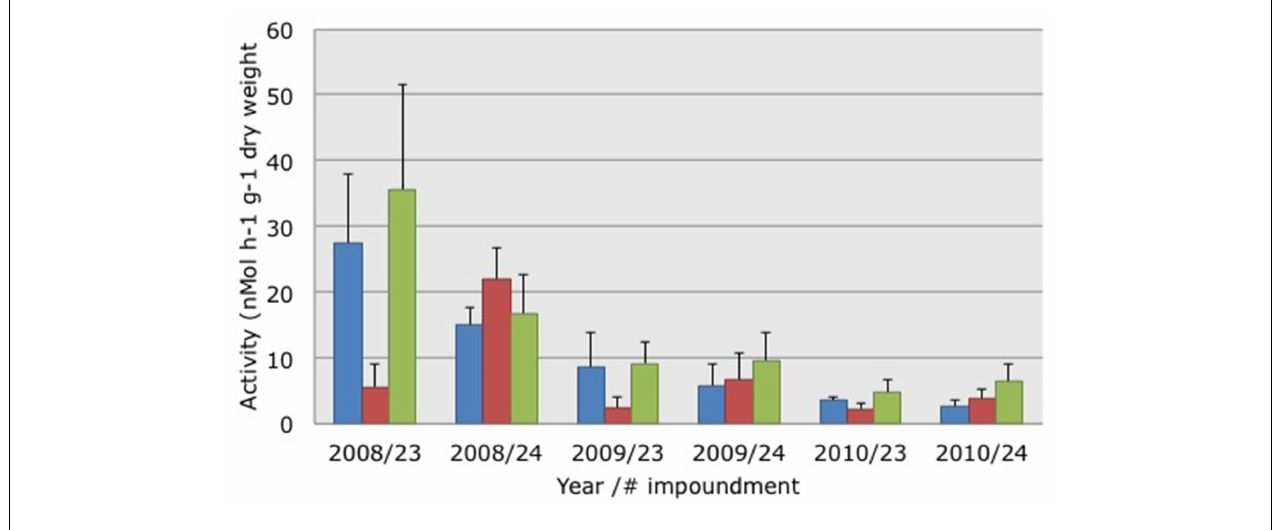
germinans . Soils were collected in March 2008, 2009, and 2010 in impoundments 23 and 24 in the Indian River Lagoon, Florida. SE are presented in brackets.